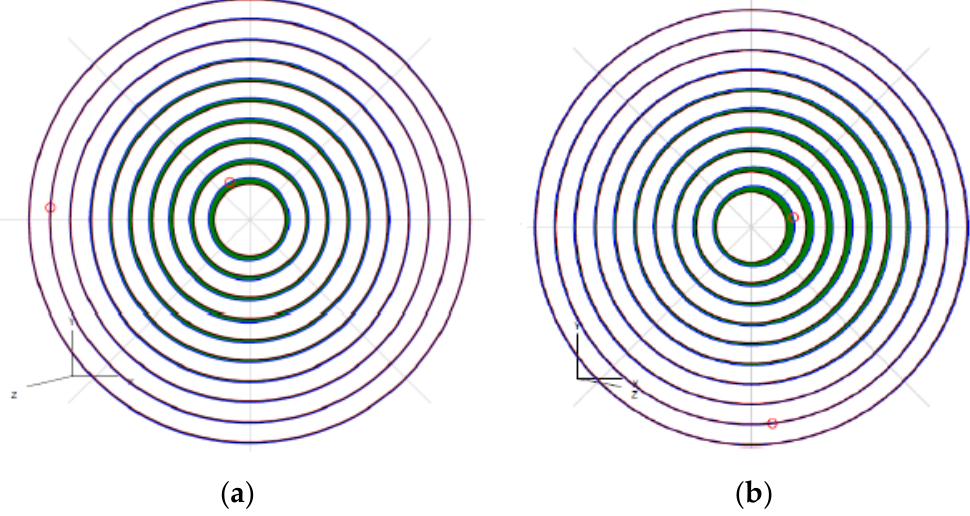
Figure 18. Cylindricity deviations ( a ) constant Z strategy; ( b ) circular pocket strategy.